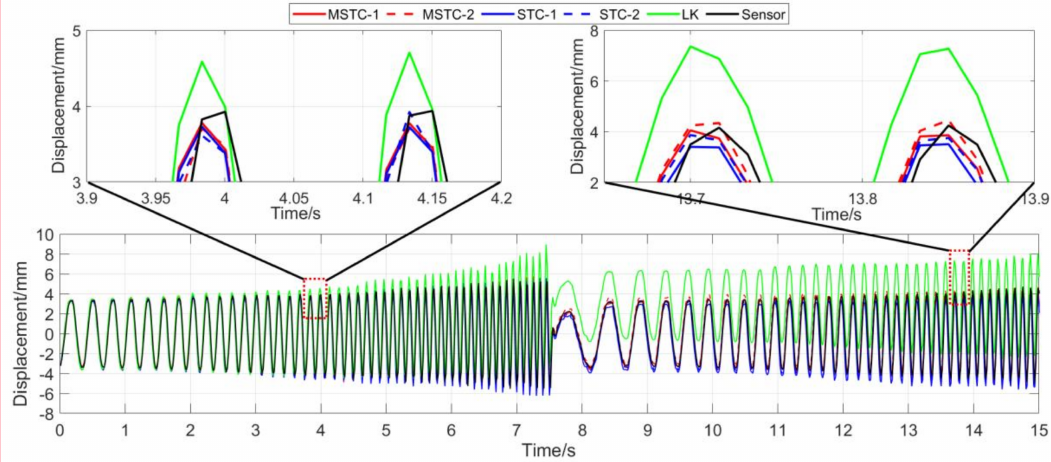
Figure 19. Displacement time history and local amplification in Scenario III (60